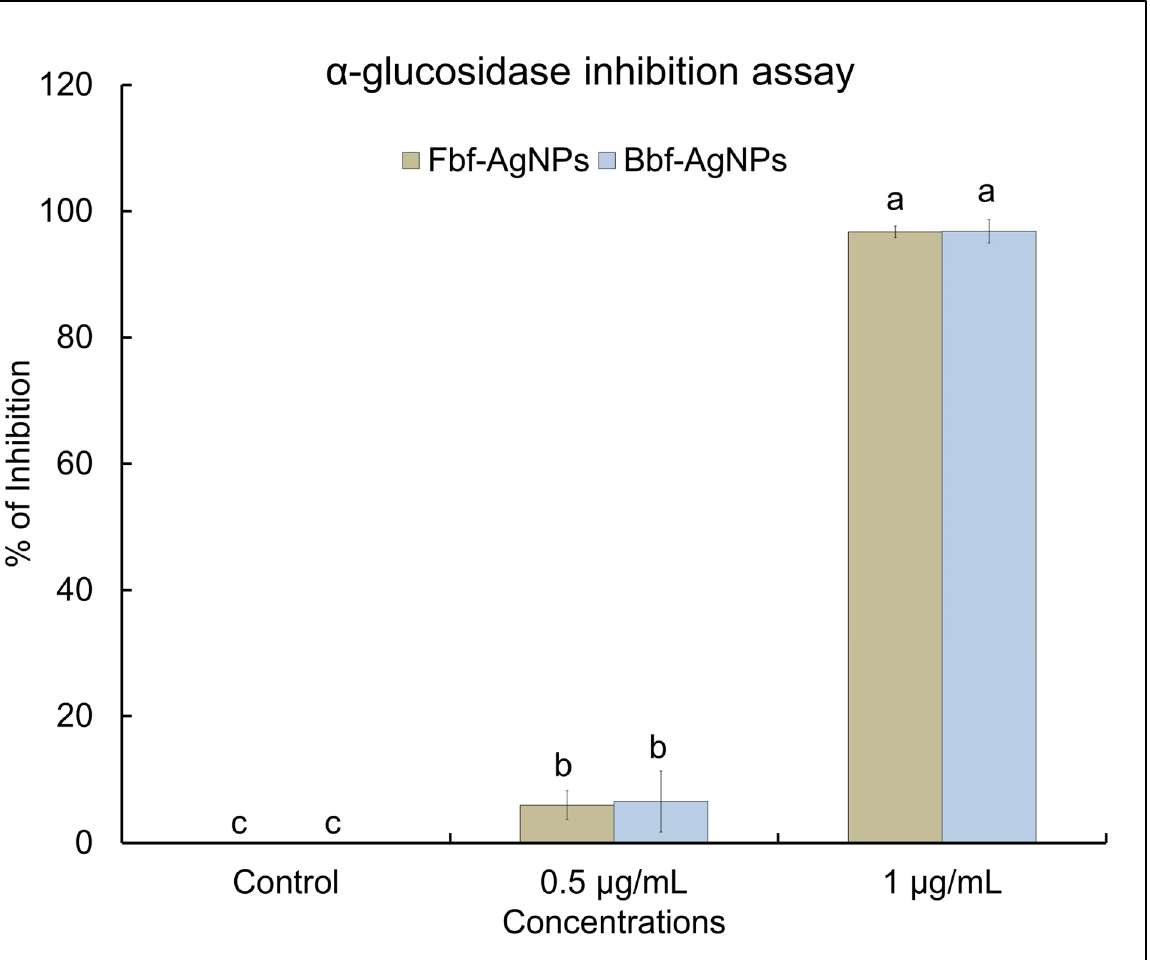
Figure 6. α - glucosidase inhibition potential of the biosynthesized Fbf-AgNPs and Bbf-AgNPs. Differences in superscript letters indicate statistically significant differences at p < 0.05.